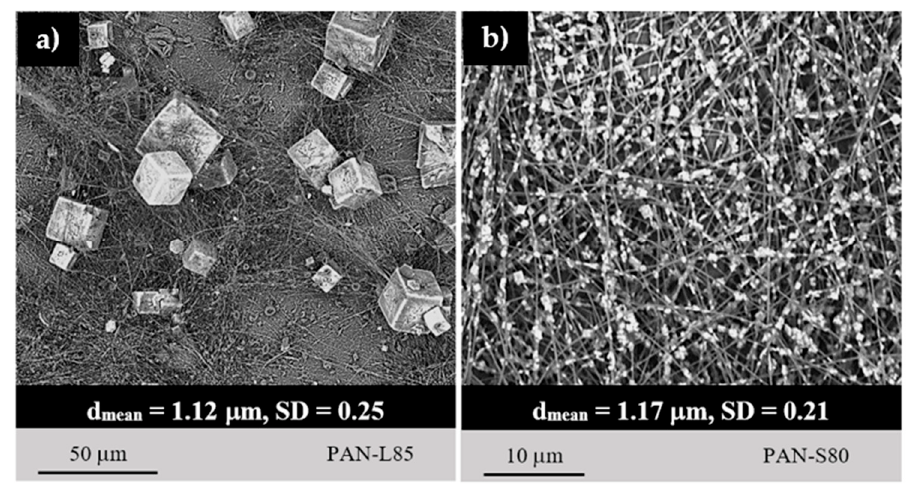
Figure 5. SEM images of coating PAN-L85 and coating PAN- S80. 247